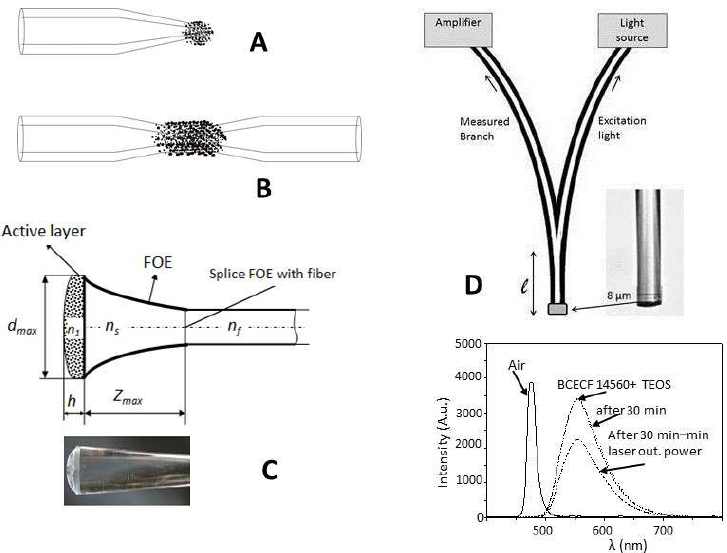
Figure 1. Optical fibers for sensor applications—( A ) a photo of a Polymer clad microstructure fiber; ( B ) a photo of a hollow fiber; ( C ) a photo of a part of S-Fiber; ( D ) a scheme of the U-fiber and a photo of the real U-shape part of a probe (reproduced from [46]); ( E ) Refractive index profile—inverted gradient index (IGI) in preform fabricated by the Modified chemical vapor deposition method at Institute of Photonics and Electronics (IPE) Prague; the photo (E) reproduced from [47] with the permission of the Czech Technical University (CTU) Editors.